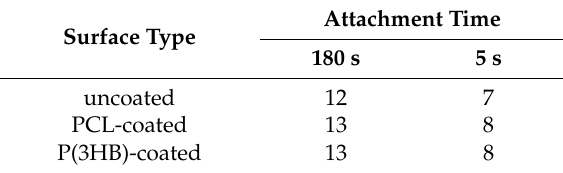
Table 1. Measured osteoblasts attached to different surface types after different attachment